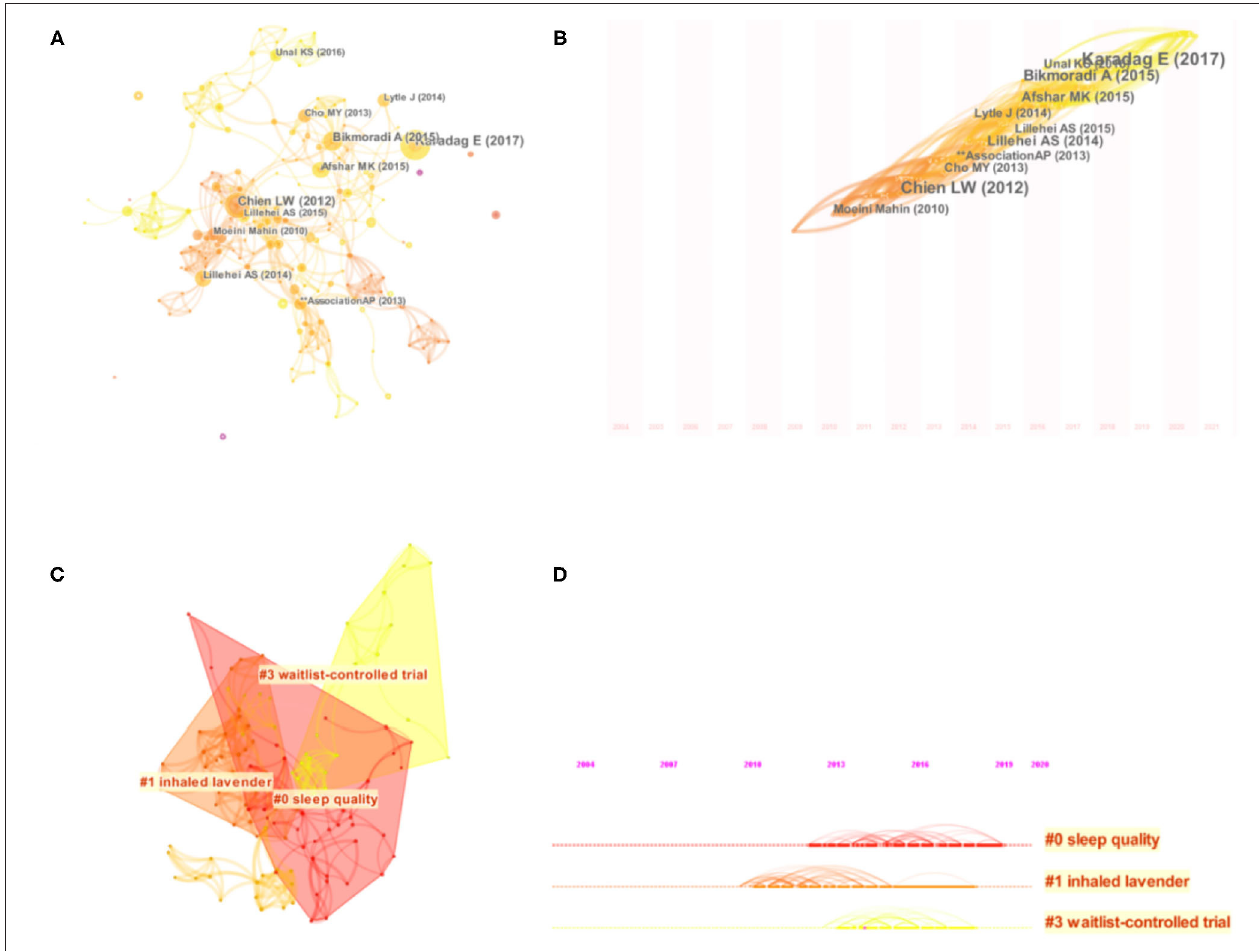
FIGURE 6 | Network map (A) , timezone view (B) , cluster map (C) and timeline (D) of the cocitation